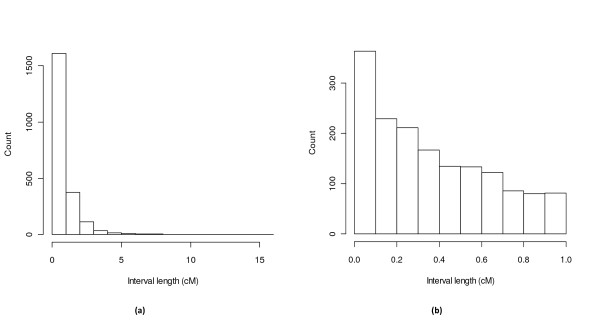
The distribution of map intervals for the BnaWAIT_01_2010a integrated map generated by JoinMap. It is highly skewed with an abundance of shorter distances. a) shows the distribution from 0-1 cM to >10 cM sections. b) shows the further partition of interval length distribution within the 0-1 cM section.